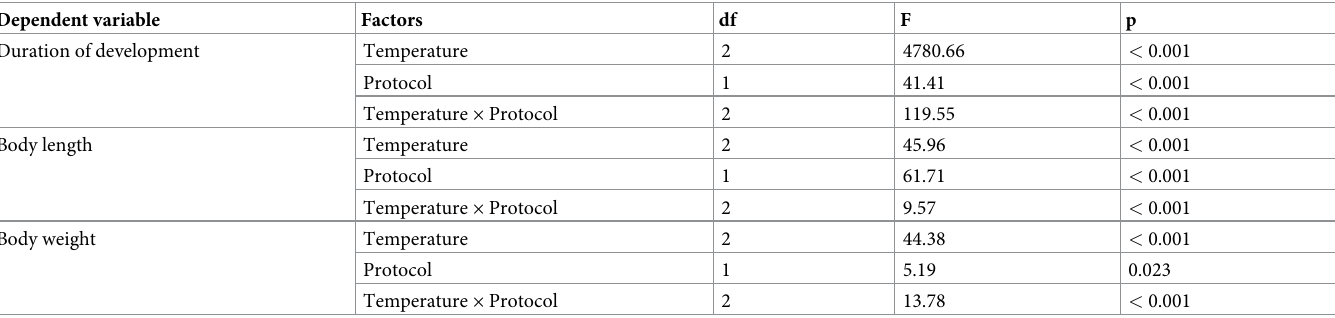
Table 1. Results of ANOVA for effects of temperature and rearing method on the development duration, length and weight of adult Necrodes littoralis . Dependent